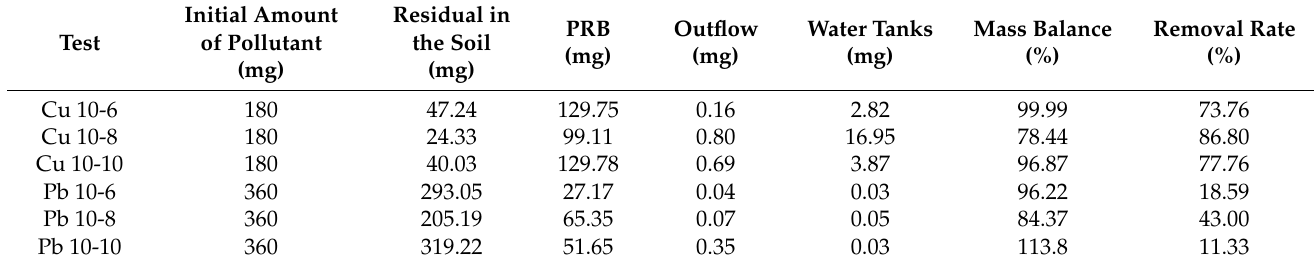
Table 2. Mass balance and removal